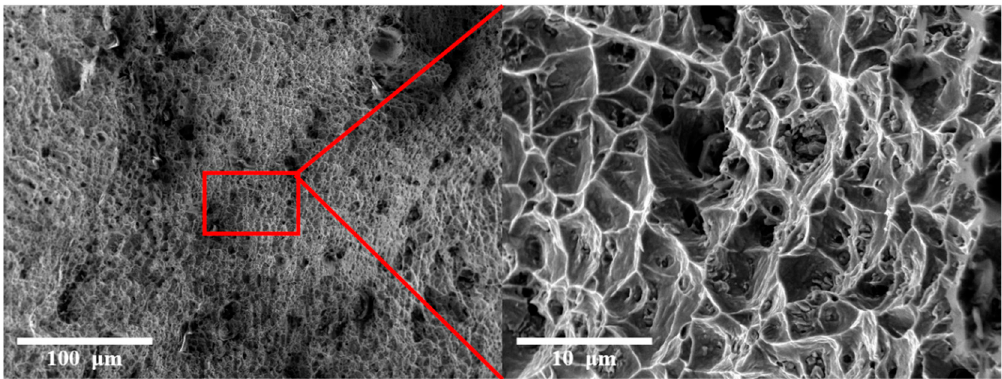
Figure 8. Comparison of UTS, YS, and elongation for WAAM and LMD-WAAM samples (800 W).